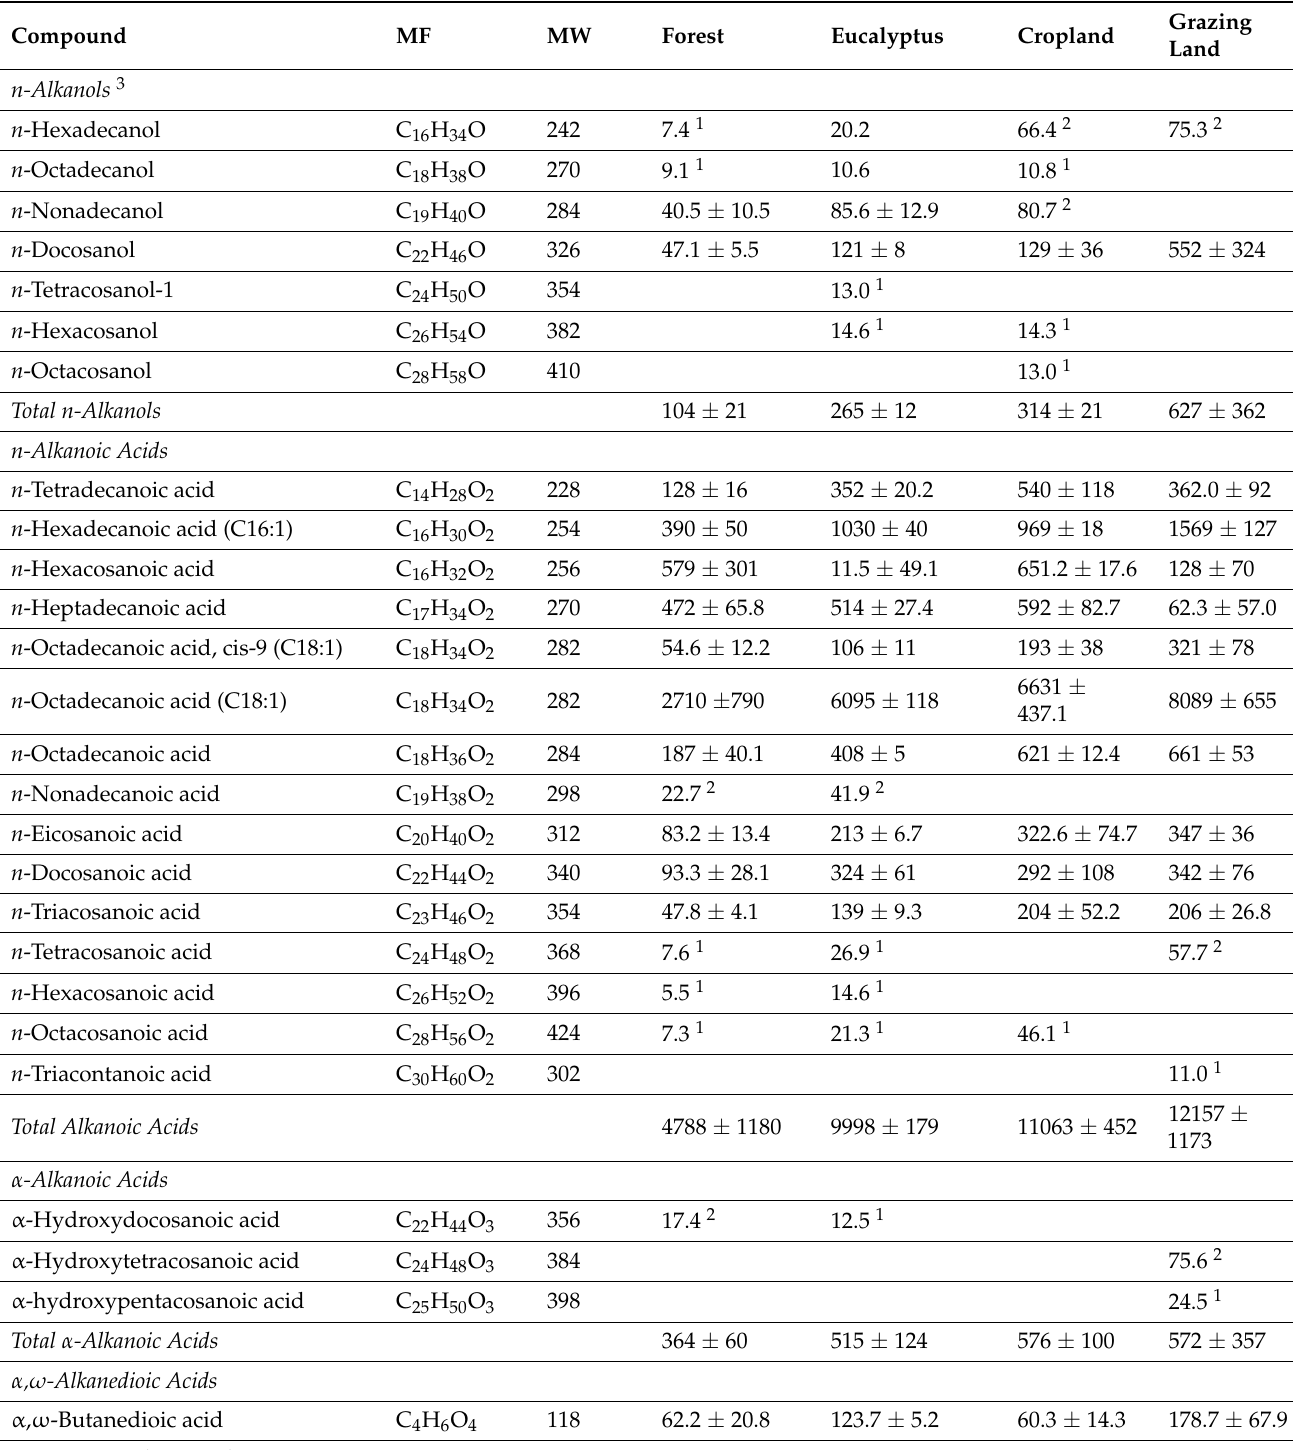
Table A2. Compounds ( µ g g − 1 C) with molecular formula (MF) and molecular weight (MW) identi- fied from base hydrolyzed of soil samples from different land-use systems in Gelawdios, Ethiopia. MF, molecular formula; MW, molecular weight. Values are mean ± SE, n = 1–3 (see below